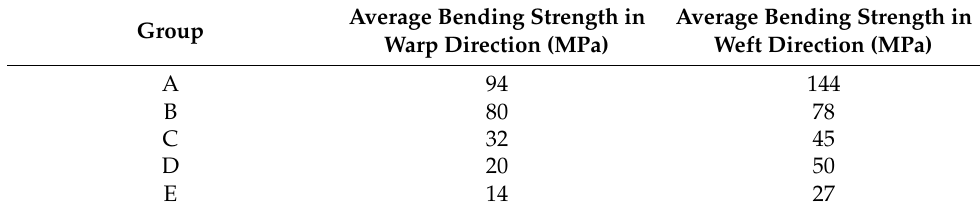
Table 4. Average bending strength in warp and weft directions.